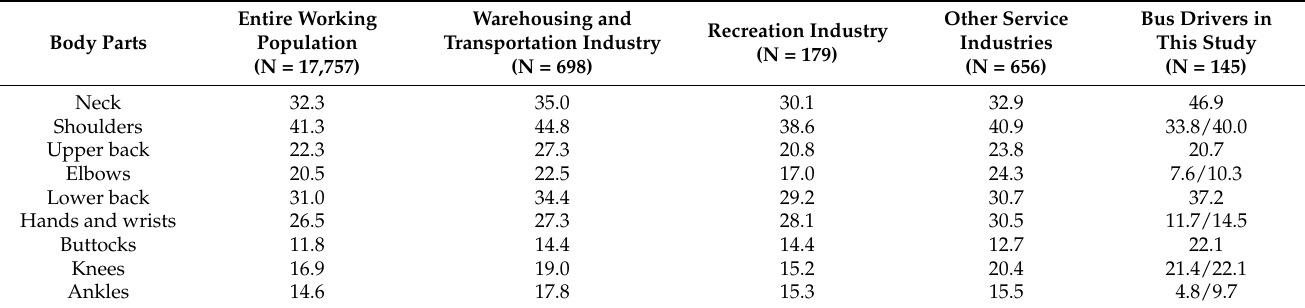
Table 3. Prevalence of musculoskeletal discomfort in various body parts for workers and workers in other industries (unit in percentage).